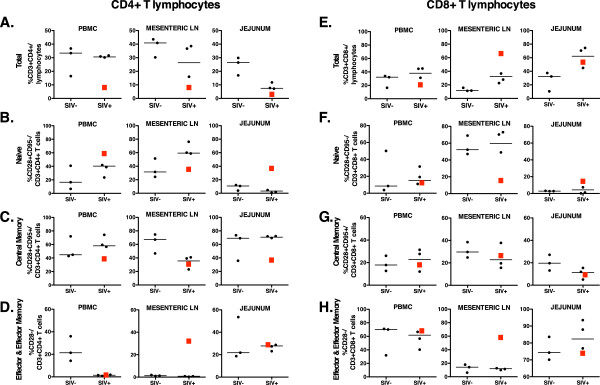
T cell memory phenotyping of SIV-infected rhesus macaques after tenofovir withdrawal. CD3 + 4+ T cells (A-D) and CD3 + 8+ T cells (E-H) from PBMC and tissue lymphoid cells collected at time of euthanasia were assessed via multiparameter flow cytometry. Values were compared to those of 3 uninfected animals. Data are reported as the frequency of CD4+ T cells (A) and CD8+ T cells (E) in the total lymphocyte population, or as the frequency of naïve cells, CD28 + CD95- (B,F), central memory cells, CD28 + CD95+ (C,G), and effector and effector memory cells, CD28- (D,H) within their respective CD4+ and CD8+ T cell populations. Animal 33091 is represented as a red square in all graphs.